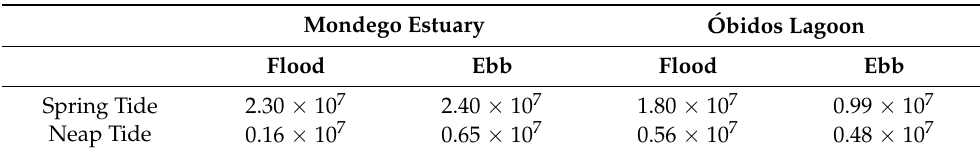
Table 5. Tidal prism (m 3 ) computed at the mouth channel section for Mondego Estuary and Ó bidos